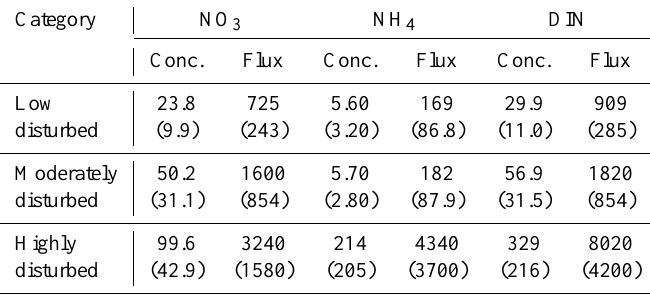
Table 4. Mean annual NO 3 , NH 4 and DIN concentrations and riverine fluxes of the three categories of watersheds between 2002 and 2012.